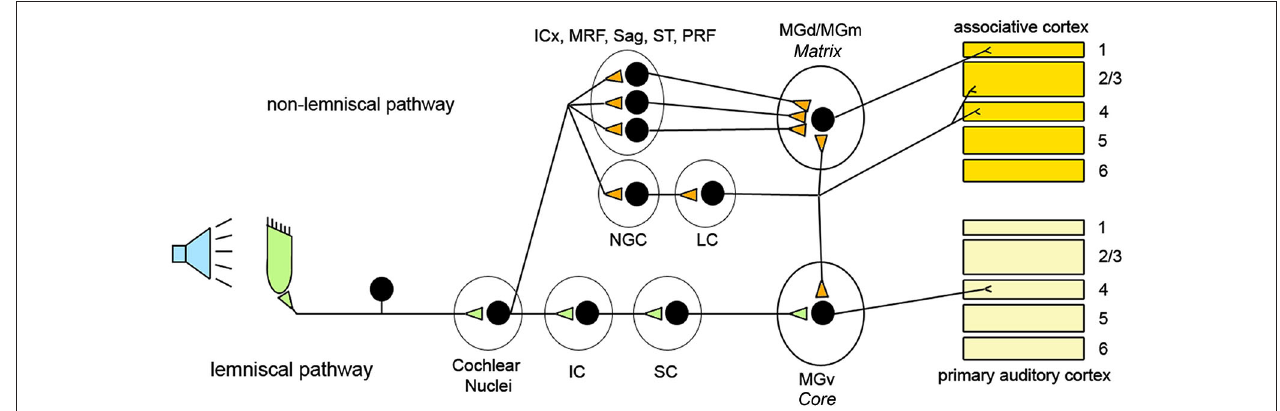
PRF: pontine reticular formation; NGC: Nucleus gigantocellularis; LC: Locus coeruleus; IC: Inferior colliculus; SC; Superior colliculus; MGd: